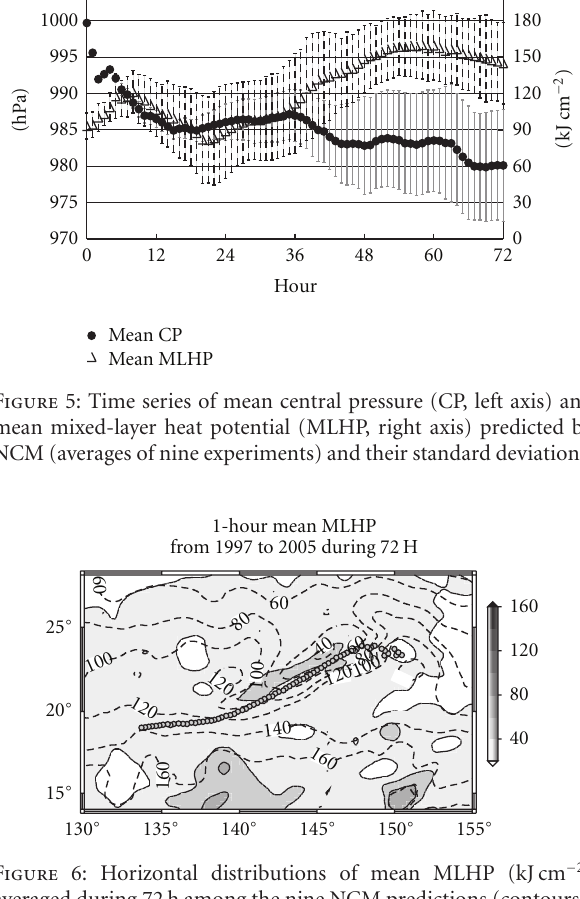
Figure 6: Horizontal distributions of mean MLHP (kJcm − 2 ) averaged during 72 h among the nine NCM predictions (contours), and of the standard deviation of MLHP (shading). MLHP values instantaneously calculated every hour were used. Hai-tang’s best track is also shown.